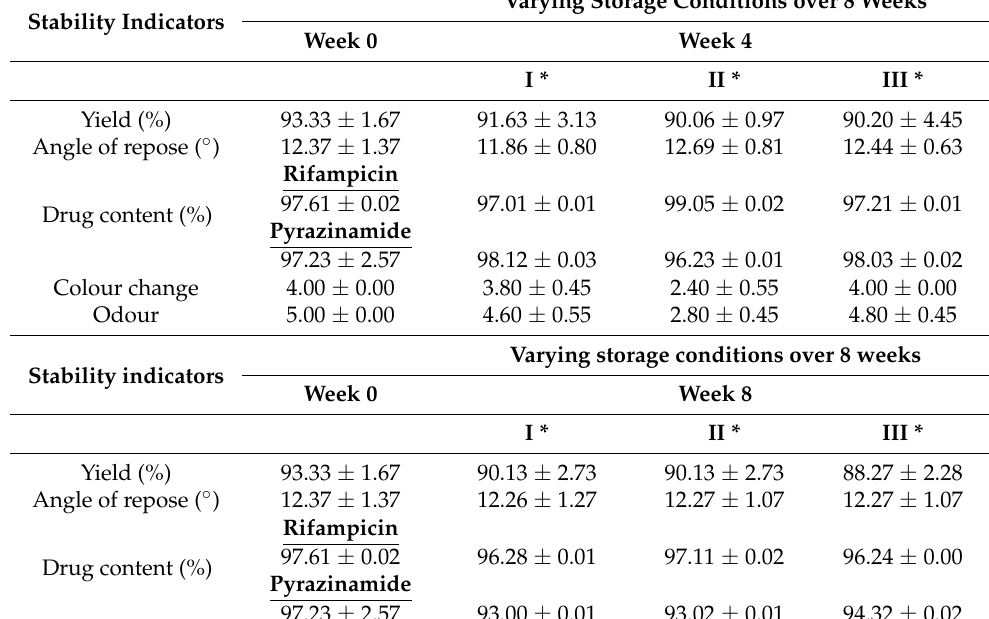
Table 8. Stability indicators for dry suspension powder over 8